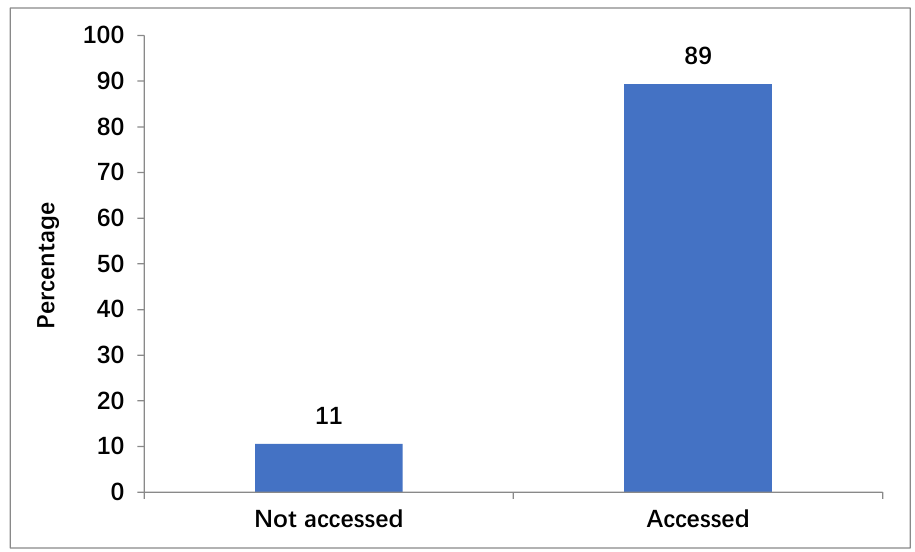
Figure 2. Percentage distribution of farmers according to access to climate information.